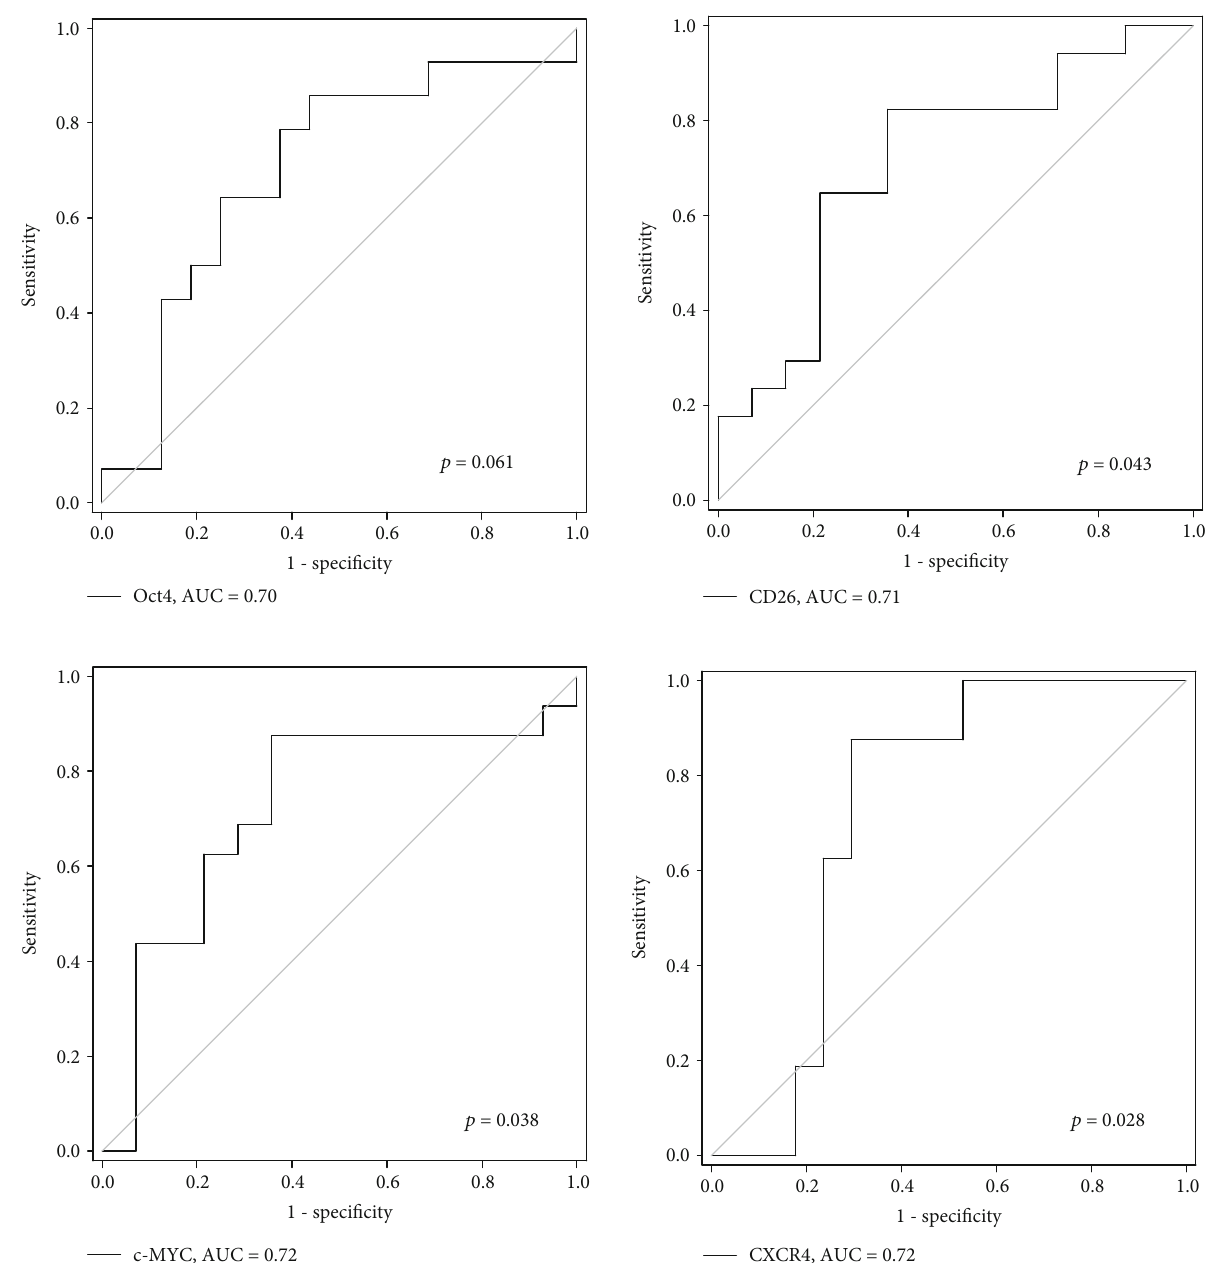
Figure 2: ROC analyses of Oct4 , CD26 , c-MYC , and CXCR4 for CRC identi fi cation from normal